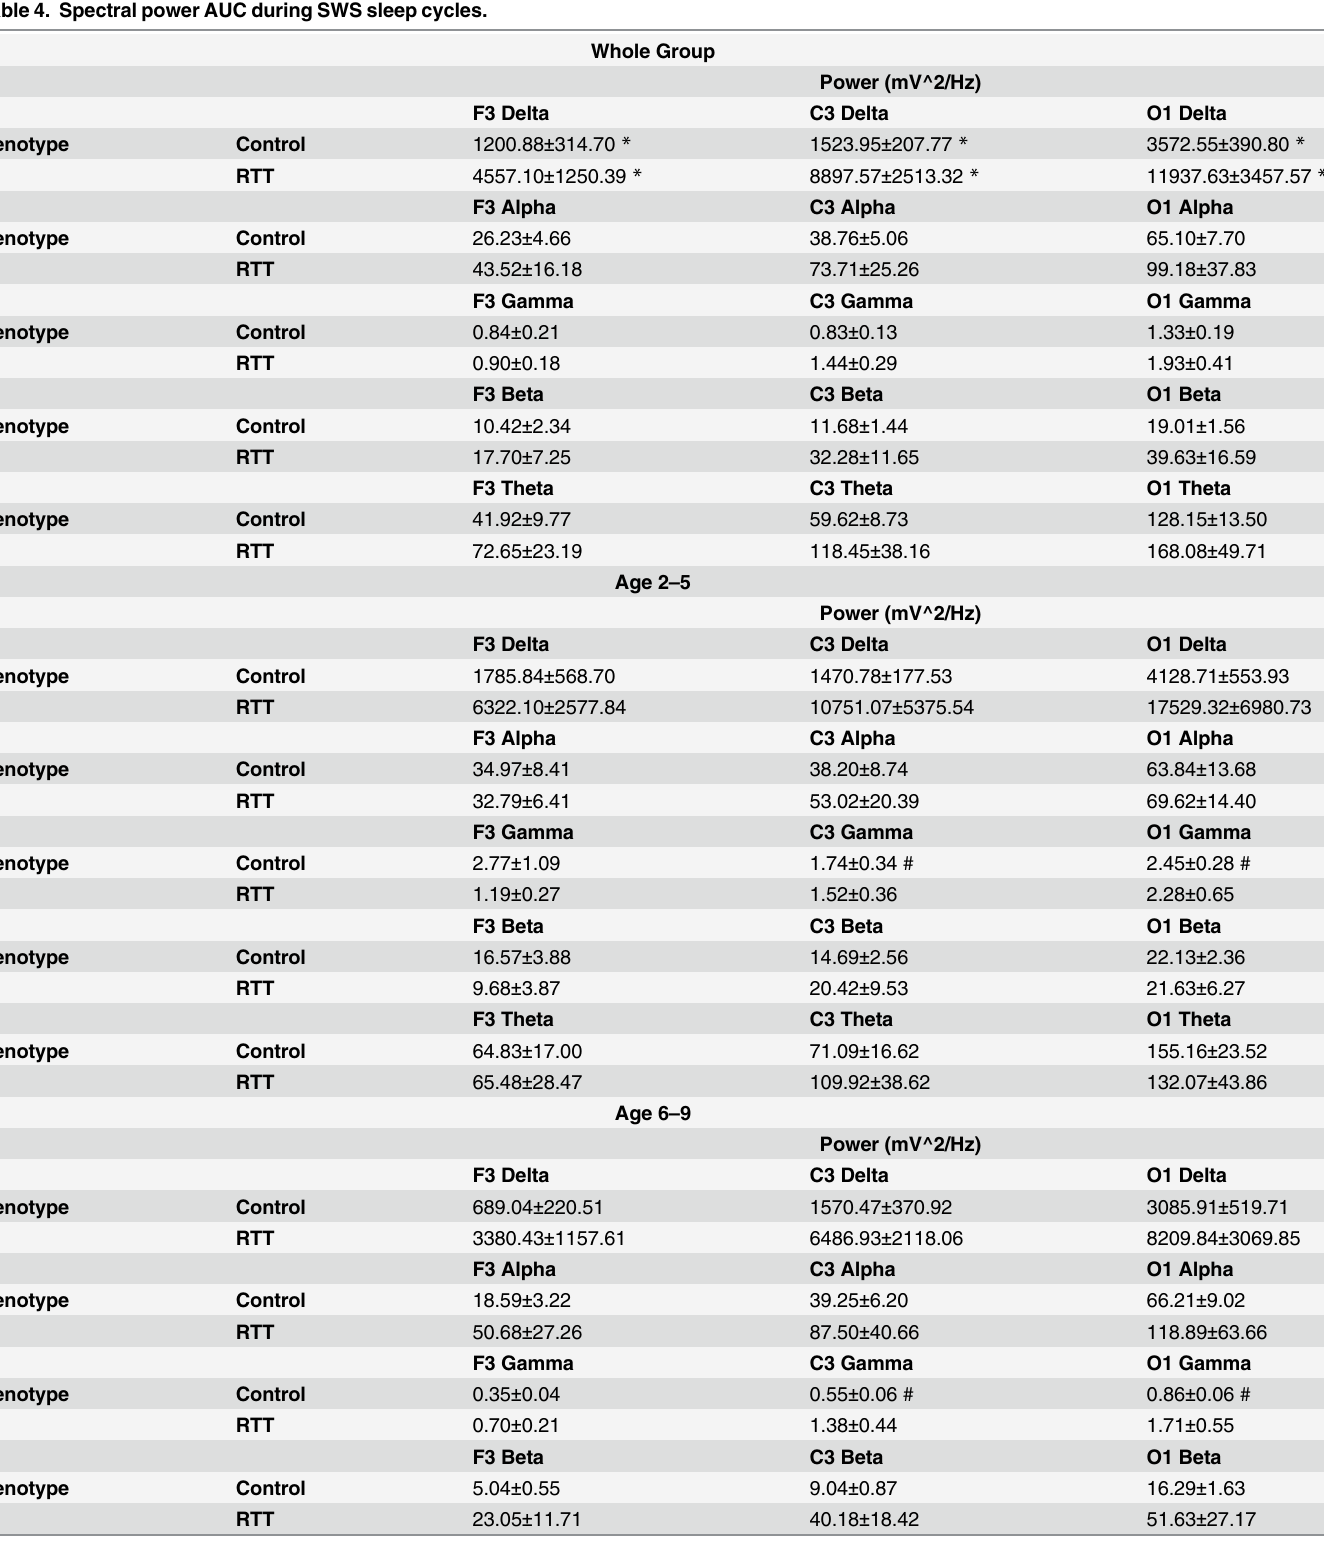
Table 4. Spectral power AUC during SWS sleep